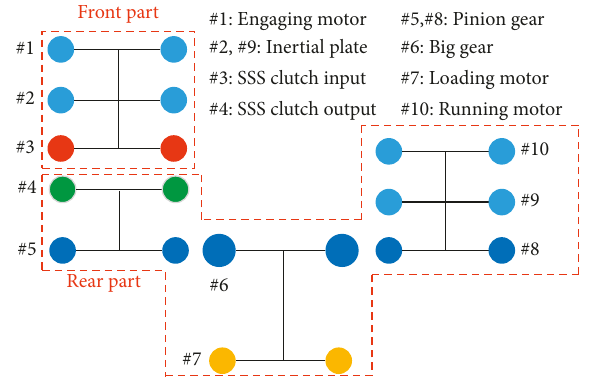
Figure 8: A lumped model of the shafting in an experimental